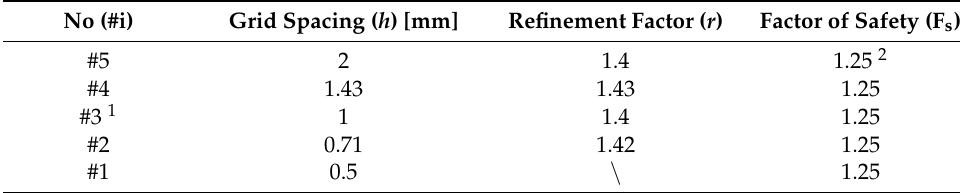
Table A1. Grids parameters for error estimation.